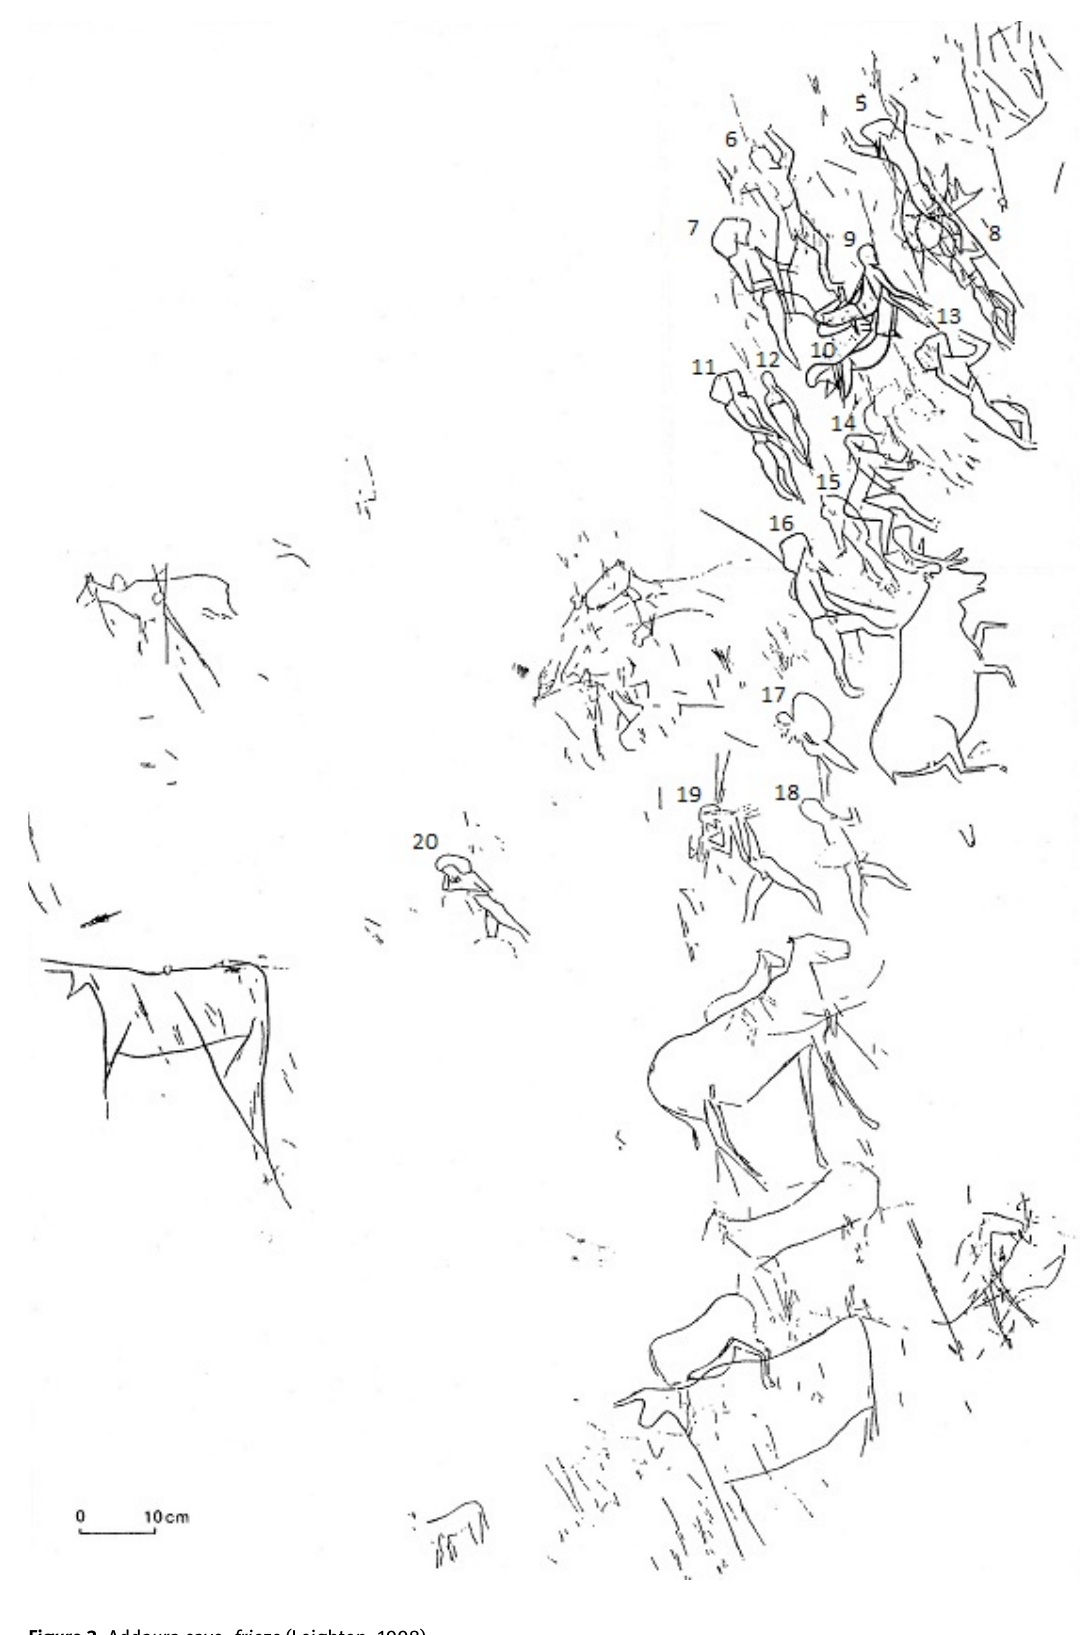
Figure 3. Addaura cave, frieze (Leighton,